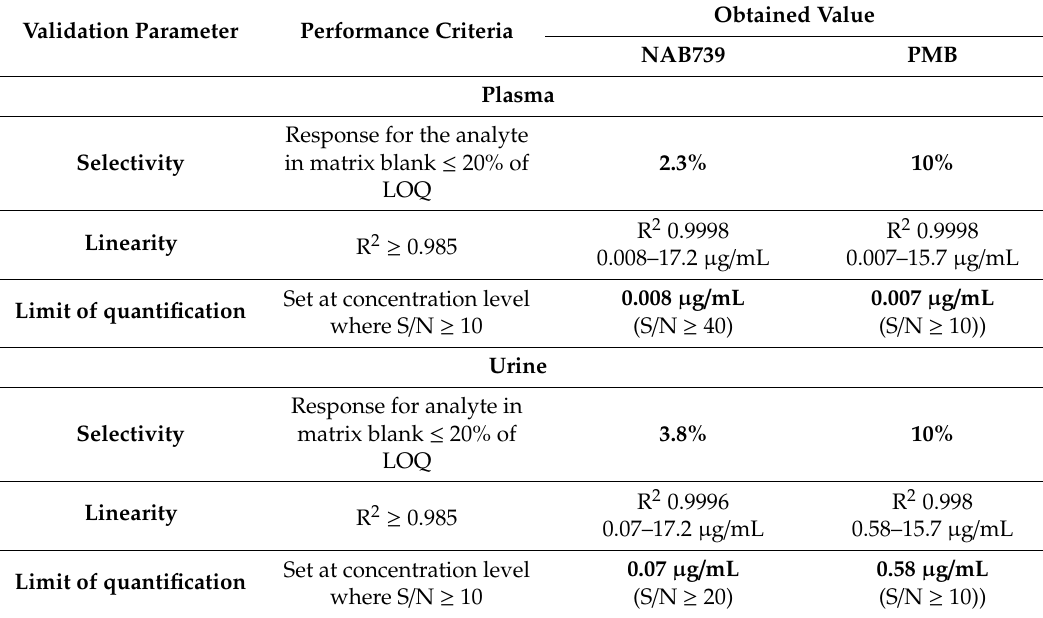
Table 2. Polymyxin analysis method